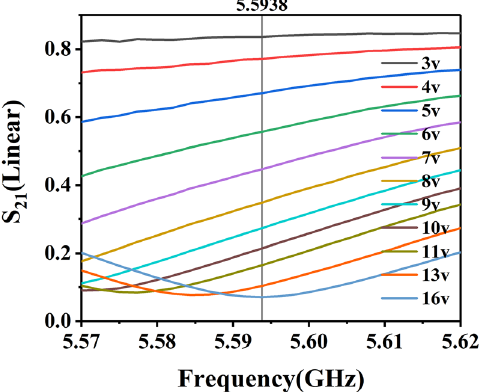
Figure 6: The experimental S 21 curves for the recon fi gurable SSPP MZIstructureshowninFigure2(b)withthebiasvoltagevaryingfrom 3 to 16